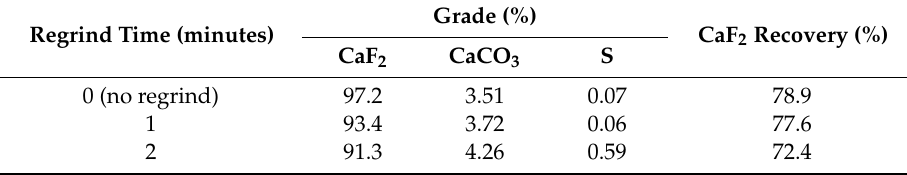
Table 10. E ff ect of concentrate regrind on CaF 2 grade and recovery.